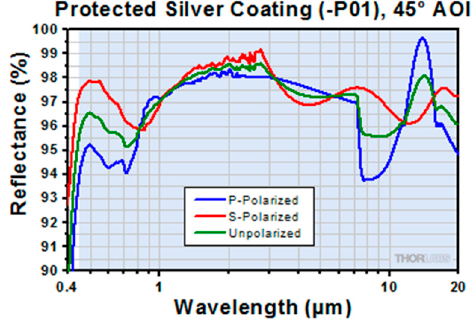
Figure 5. Reflectivity of the reflector.